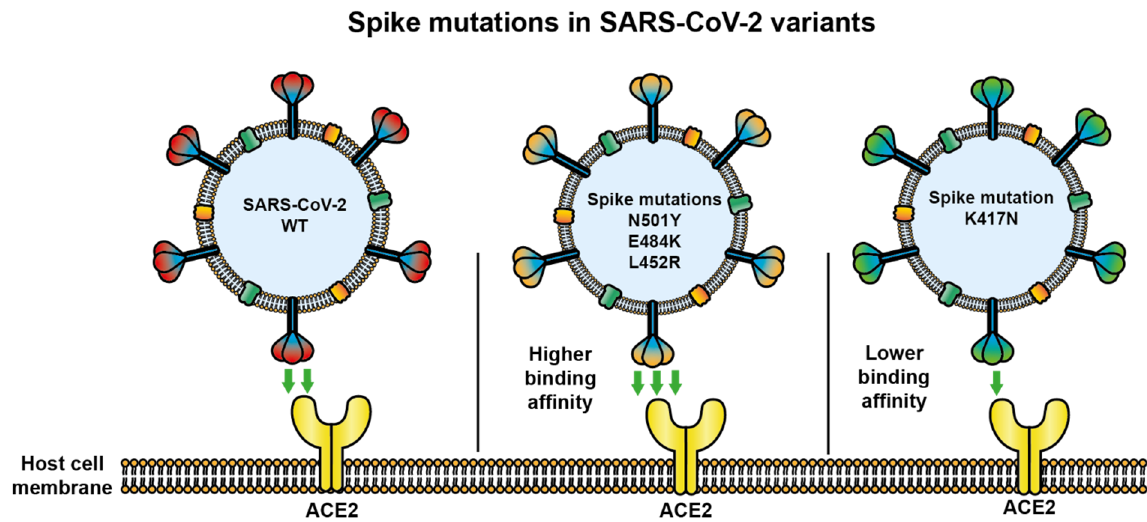
Figure 3. SARS-CoV-2 variants modify their binding capability to angiotensin converting enzyme 2 (ACE2). Variants of SARS-CoV-2 with altered glycoprotein S can modify their interaction with the viral receptor ACE2 by increasing its binding capacity (variant N501Y, E484K, or L452R) or inhibiting it (variant K417N) during infection.